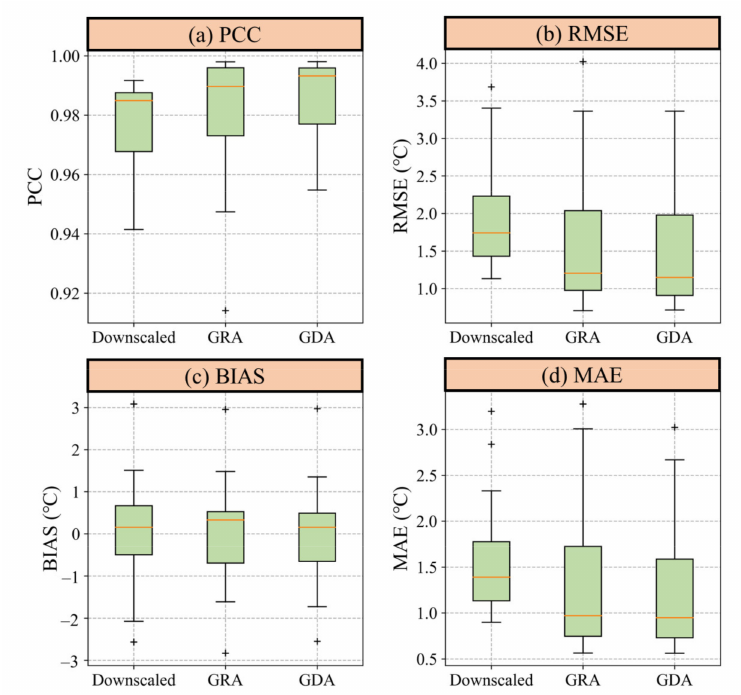
Figure 10. The box plots of the statistical metrics for 20 validation stations. Boxes from left to right in each subplot represent downscaled temperature, calibrated temperature by GRA, and calibrated temperature by GDA, respectively.